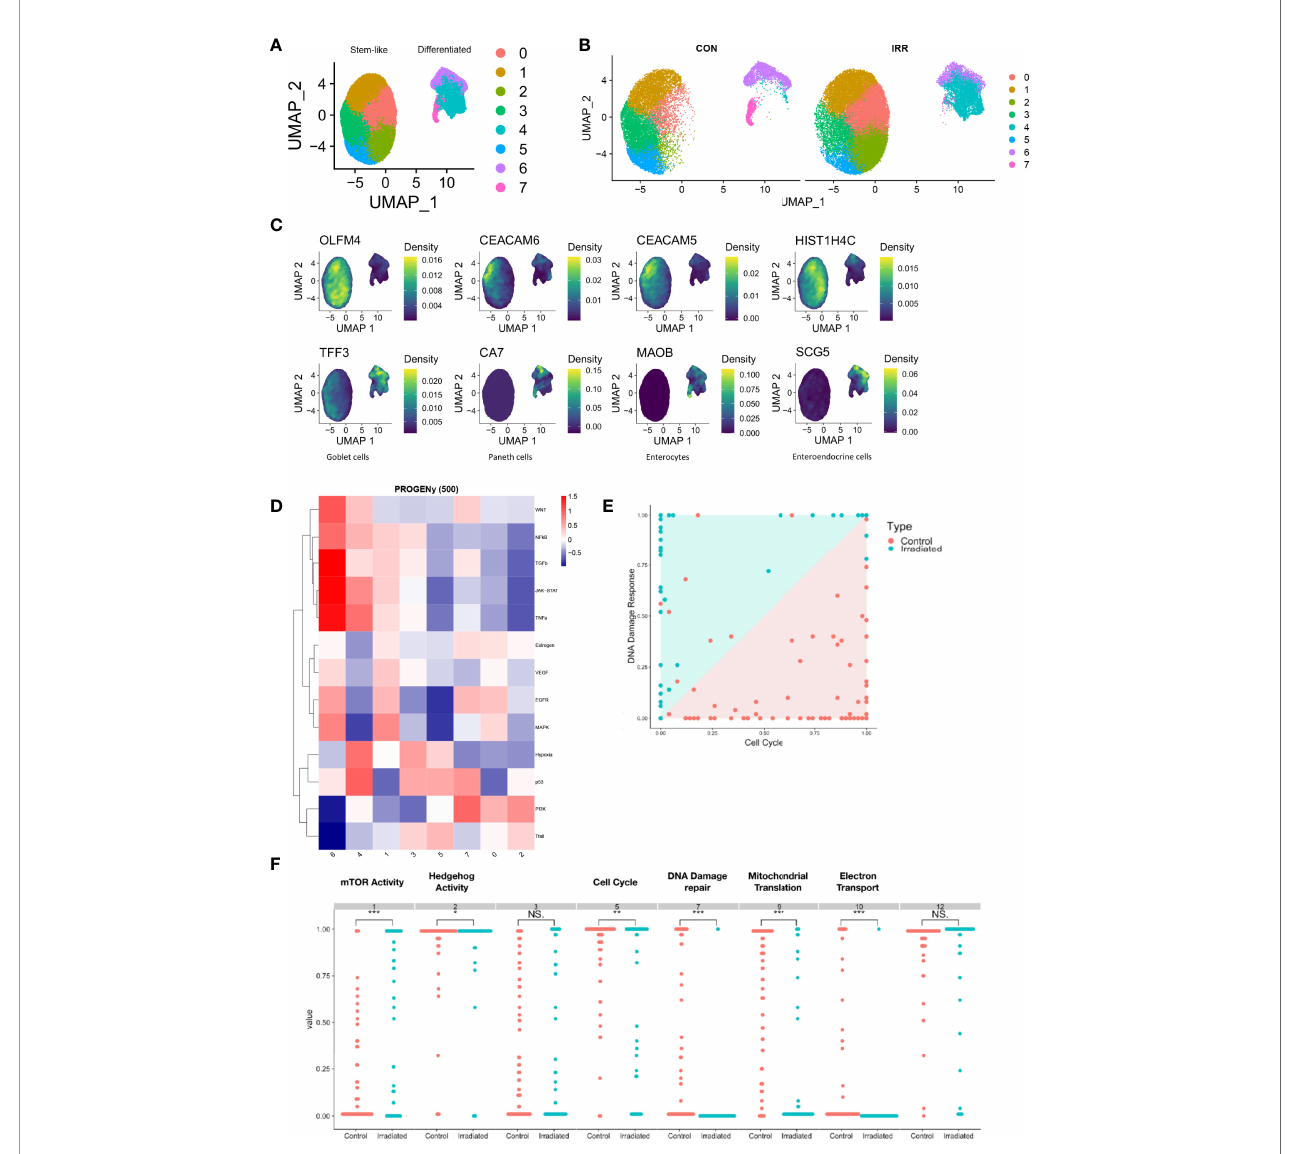
FIGURE 4 | Single-cell RNA sequencing of irradiated PDOs shows cell type speci fi c response to radiation and increase in mTOR activity in radiated cells. UMAP dimensional reduction of single-cell sequencing of irradiated (IRR) and control (CON) radiation sensitive PDOs displayed merged (A) and separately (B) . (C) Markers of stem-like and differentiated clusters. (D) Heatmap illustrating pathway responsive genes (PROGENy) for each cell cluster. (E, F) Scalable Bayesian Boolean Tensor Factorisation (SBBTF) and pathway analysis showing enrichment of mTOR activity on irradiated cells. *p < 0.05, **p < 0.01, ***p < 0.001, NS, Not signi fi